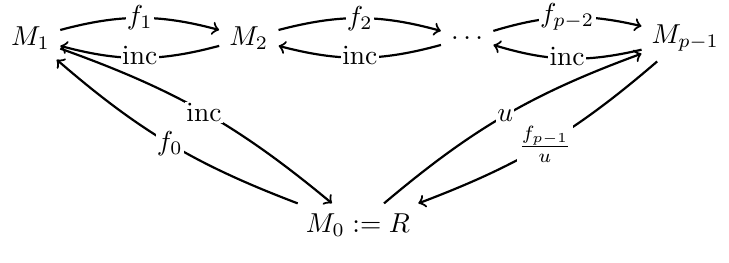
Figure 5. The NCCR of BP( p; p